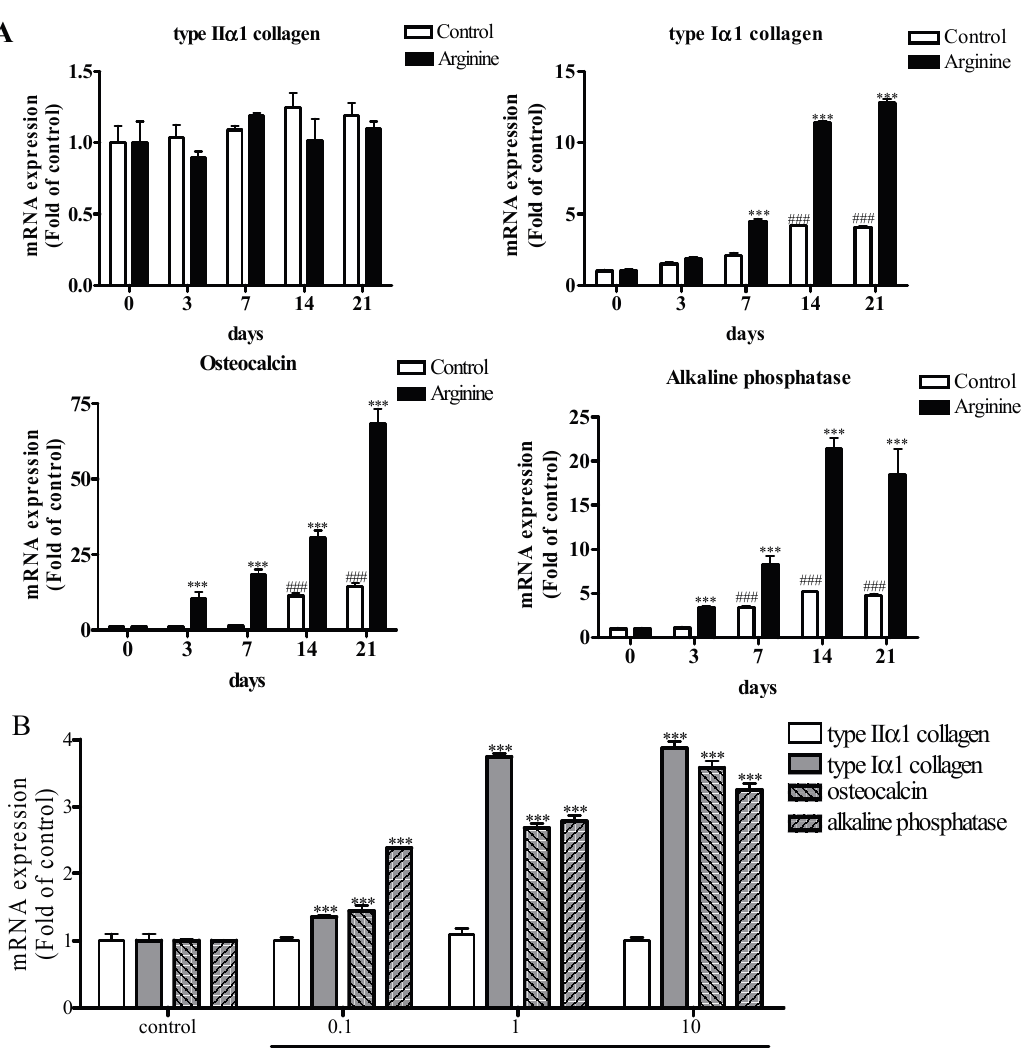
Figure 2. Effect of arginine on osteoblastogenesis in MSCs. ( A ) Time-dependent expression of osteogenic marker genes during the differentiation of MSCs. Osteogenic differentiation was induced in MSCs for 21 days by using arginine 1 μ M under osteogenic conditions. The levels of mRNA expression of type II α 1 collagen, type I α 1 collagen, osteocalcin, and alkaline phosphatase were measured using qRT-PCR, and normalized relative to β -actin expression; ( B ) Dose-dependent effect of arginine on the mRNA expression of osteogenic markers; ( C ) Temporal response of arginine on mineralization. Mineralized nodules observed following Alizarin red S staining of undifferentiated cells ( A , a ) and of cells at 3 days ( B , b ), 7 days ( C , c ), 14 days ( D , d ), and 21 days ( E , e ) after culturing with or without 1 μ M arginine ( F – J , f – j ). The line graph shows the staining intensity of Alizarin red S; ( D ) Dose-dependent effect of arginine on mineralization. The bar graph shows the intensity of Alizarin red S staining; ( E ) The mRNA expression of Runx2, DIx5, and osterix transcription factors. Fold-differences were calculated as the relative expression as compared with the expression in control cells. The results are representative of three other experiments, and each bar represents the mean ± S.E.M. ### p < 0.001 compared with 0 days; * p < 0.05 and *** p < 0.001 compared with